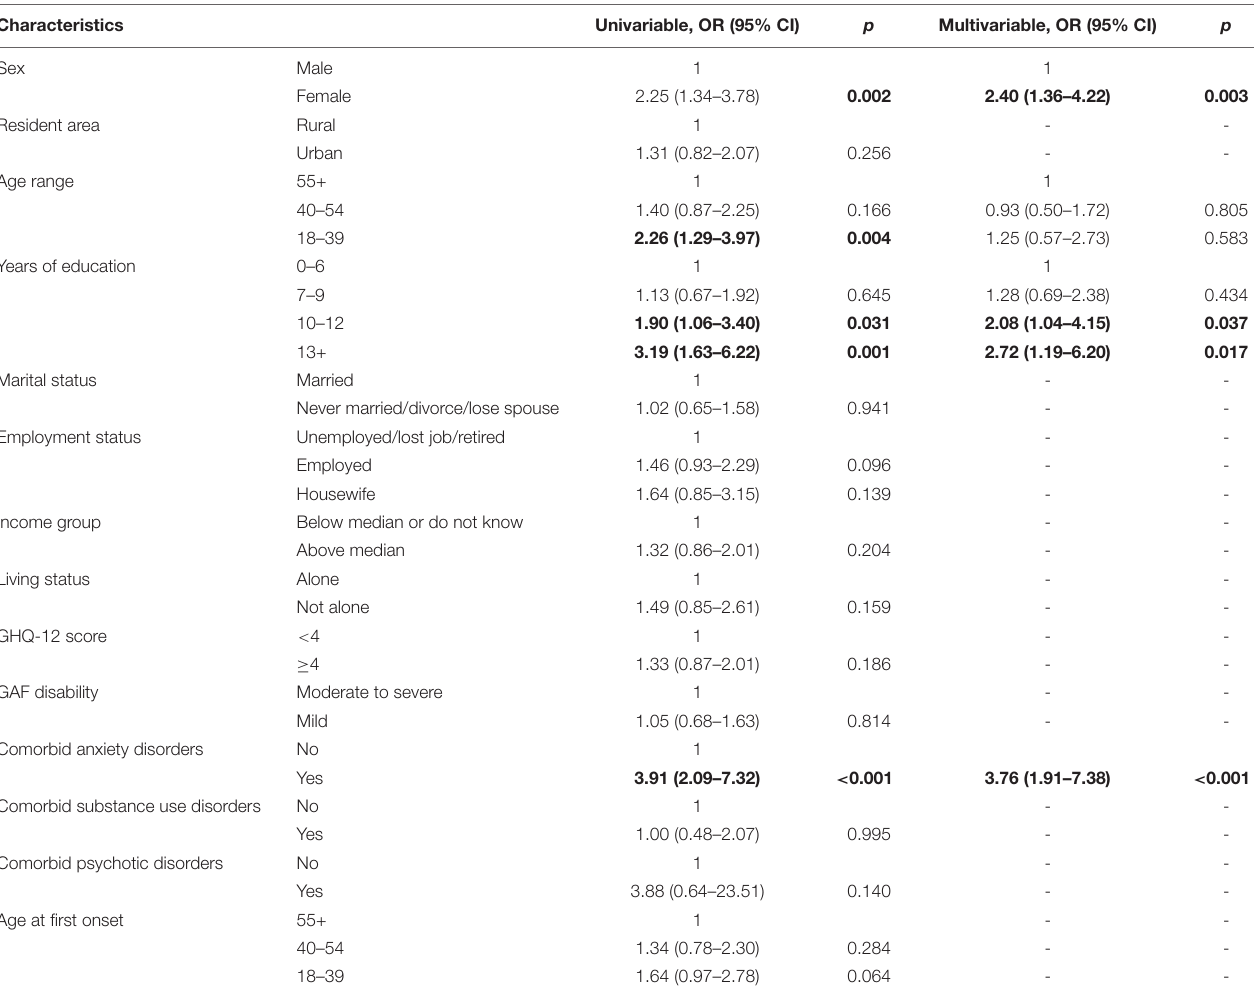
TABLE 4 | Association between demographic and clinical characteristics and help-seeking (yes/no) in individuals with MDD.